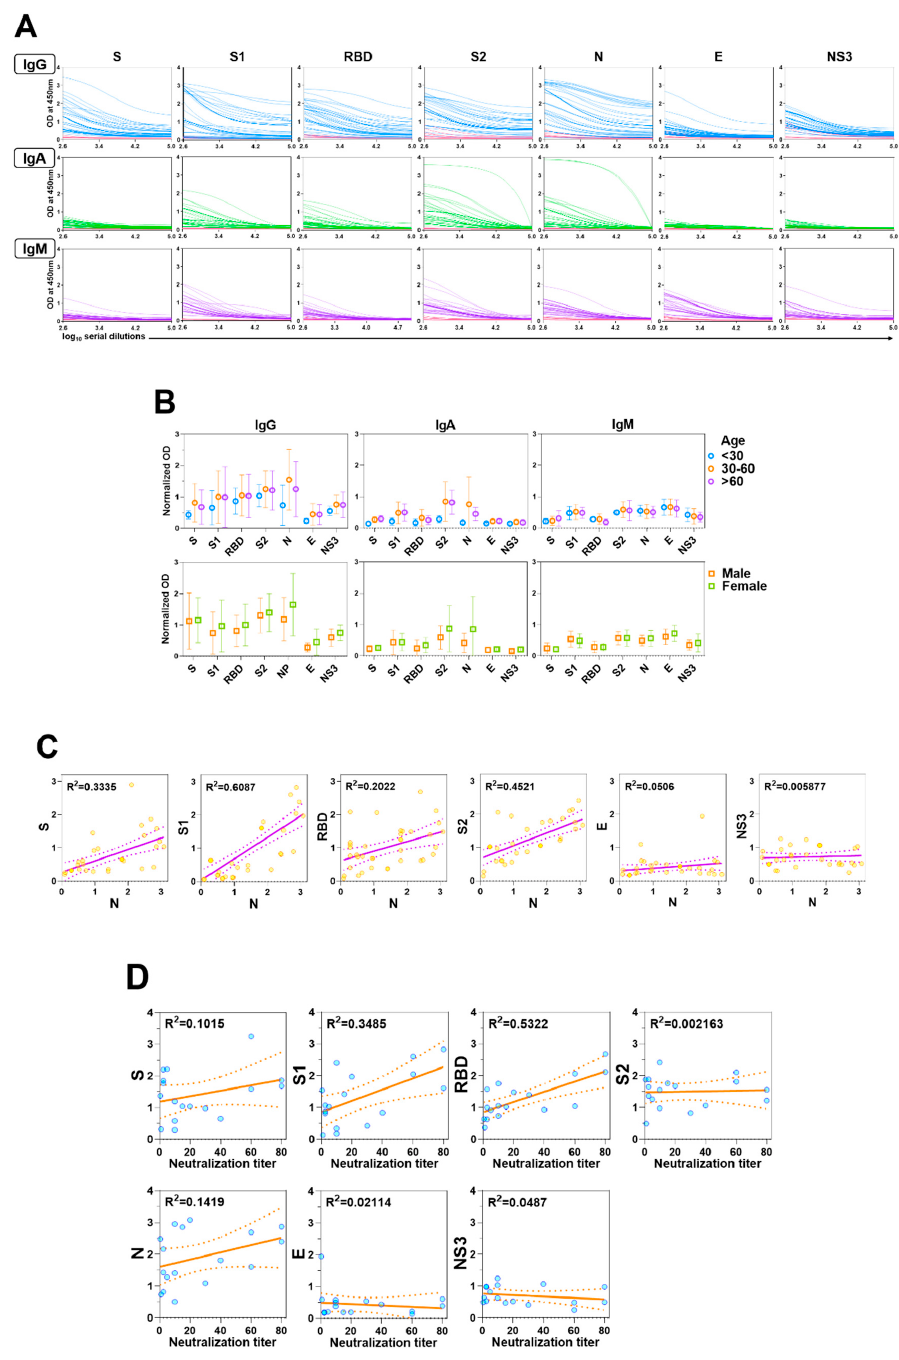
Figure 1. Antibody responses in patients with COVID-19. ( A ) Levels of serum IgG, IgA, and IgM antibodies against S, S1, RBD, S2, N, E, and NS3 of SARS-CoV-2 were measured by ELISA. Blue (IgG), green (IgA), and purple (IgM) lines represent the antibody titers of individual COVID-19 positive sera, pink lines represent negative control sera. ( B ) Each dot represents an individual antibody titer, and groups are divided by age and sex. ( C ) Correlation of anti-N responses with other antiviral protein responses in patients with COVID-19. Correlations of the values were assessed by linear regression. ( D ) Correlations between neutralization titer (x-axis) and each antibody response to the viral protein of SARS-CoV-2 (y-axis) are shown. Each dot indicates the neutralization titer of serum antibodies of patients with COVID-19, as determined by calculating the highest dilution of serum that prevents infection of 50% of inoculations and antiviral protein titers (IgG) of human sera, as determined by